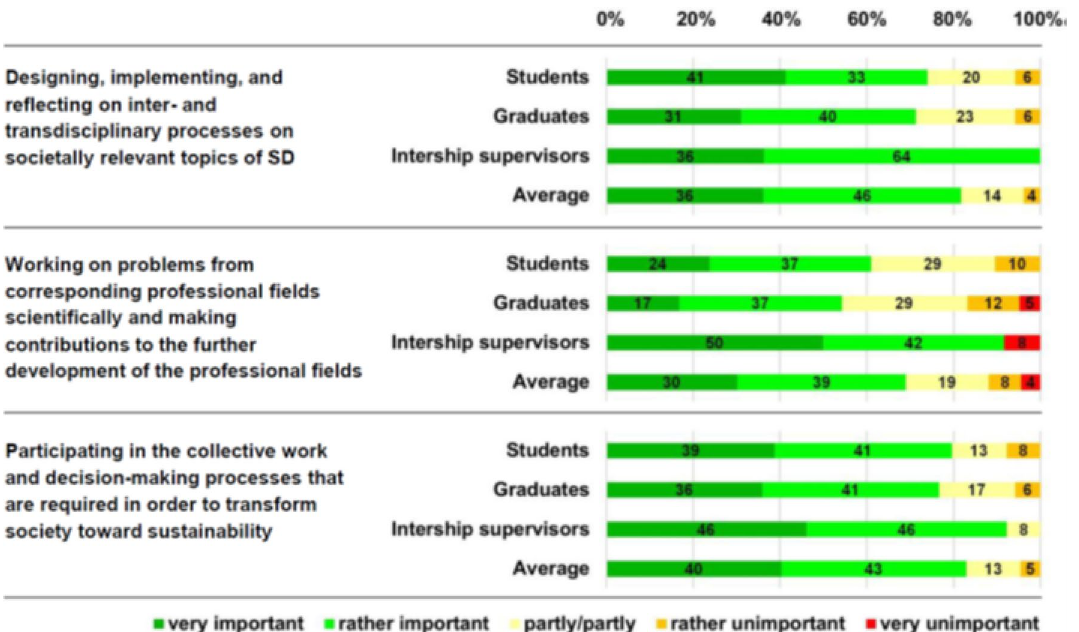
Fig. 4 Assessment regarding the importance of fostering in respect of the action competencies from the perspective of students, graduates, and internship supervisors, as well as the average of the three estimations in % (students are N = 104/105/103; graduates N = 87/83/86; and internship supervisors N =